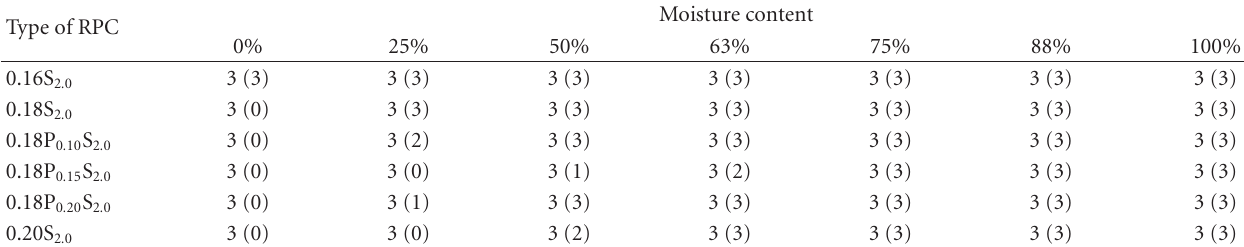
Table 2: Statistical results of explosive spalling tests on RPC with various moisture contents.